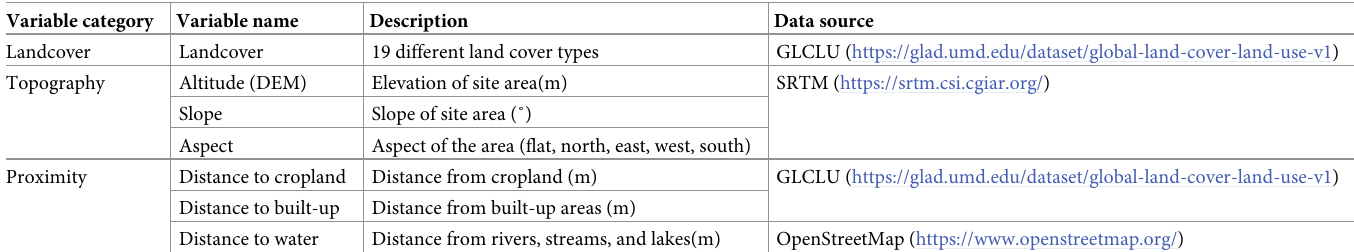
Table 1. Water deer environmental variable